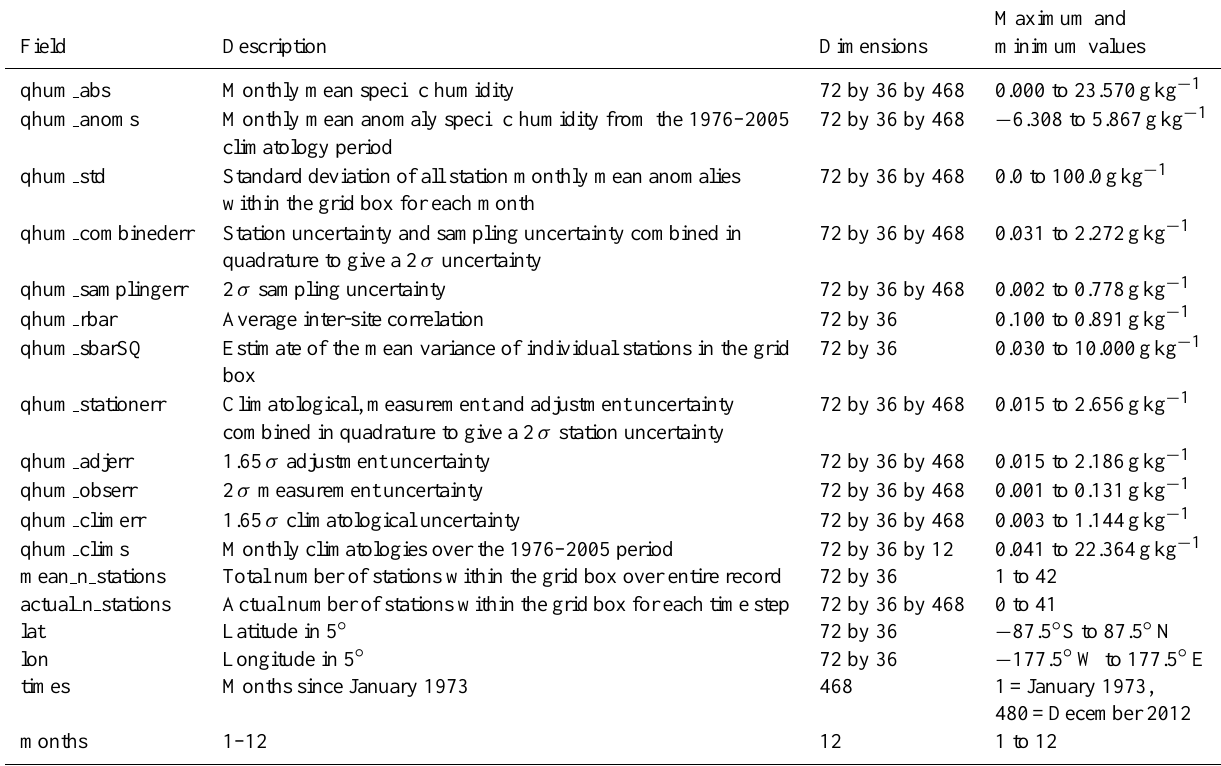
Table 3. Description of data contained in the HadISDH CF-compliant netCDF